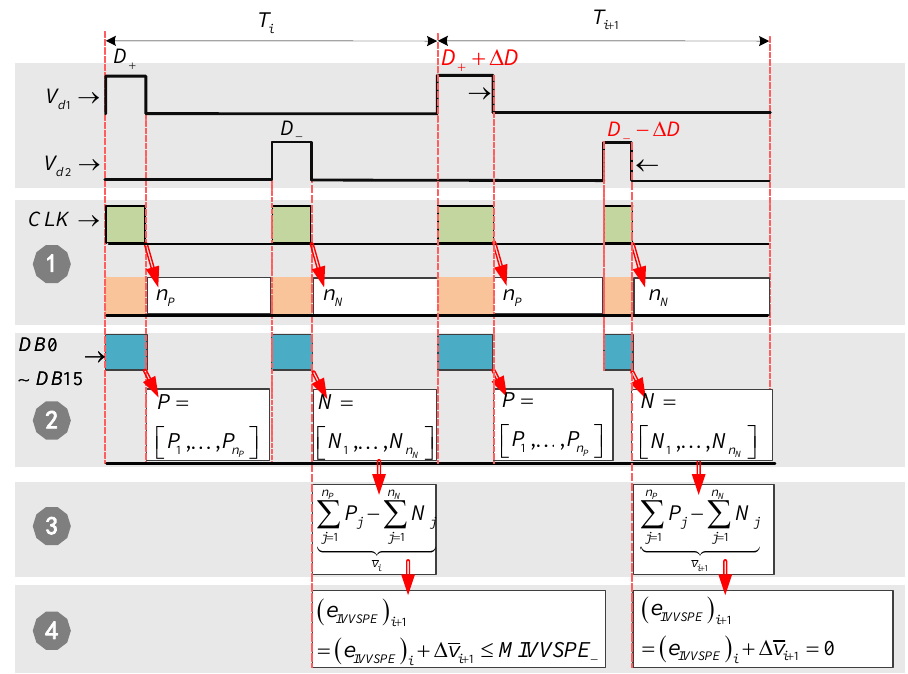
Figure 13. The block diagram of the parallel operation for negative DC bias suppression strategy. In Figure 13, the integral value of volt-second product error increases negatively, ≤ MIVVSPE − . In order to reset ( e and ( e IVVSPE ) i transformer from entering the negative saturation state, the duty cycle of v 1 in